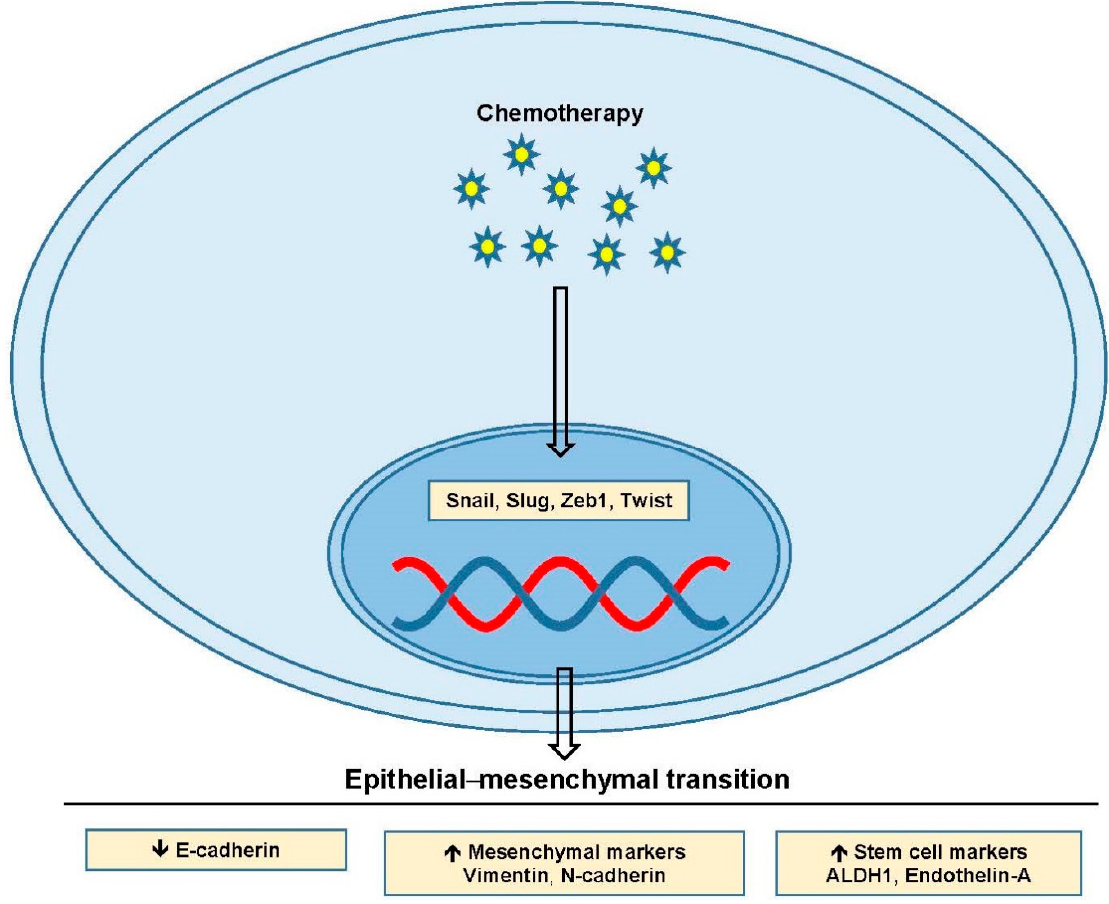
Figure 3. Epithelial–mesenchymal transition. Upregulation of Snail, Slug, Zeb1 and Twist lead to changes in mesenchymal and stem cell markers including downregulation of E-cadherin, and upregulation of vimentin, N-cadherin, ALDH1 and endothelin-A. Abbreviations: aldehyde dehydrogenase-1 (ALDH1).